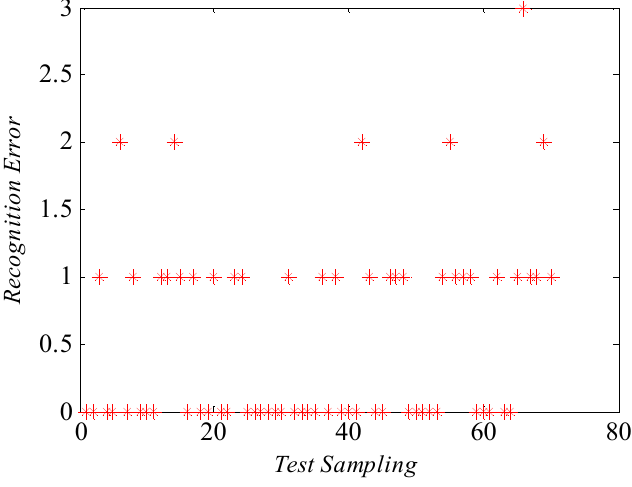
Figure 13. Recognition distribution of error when “spread” was 0.145.